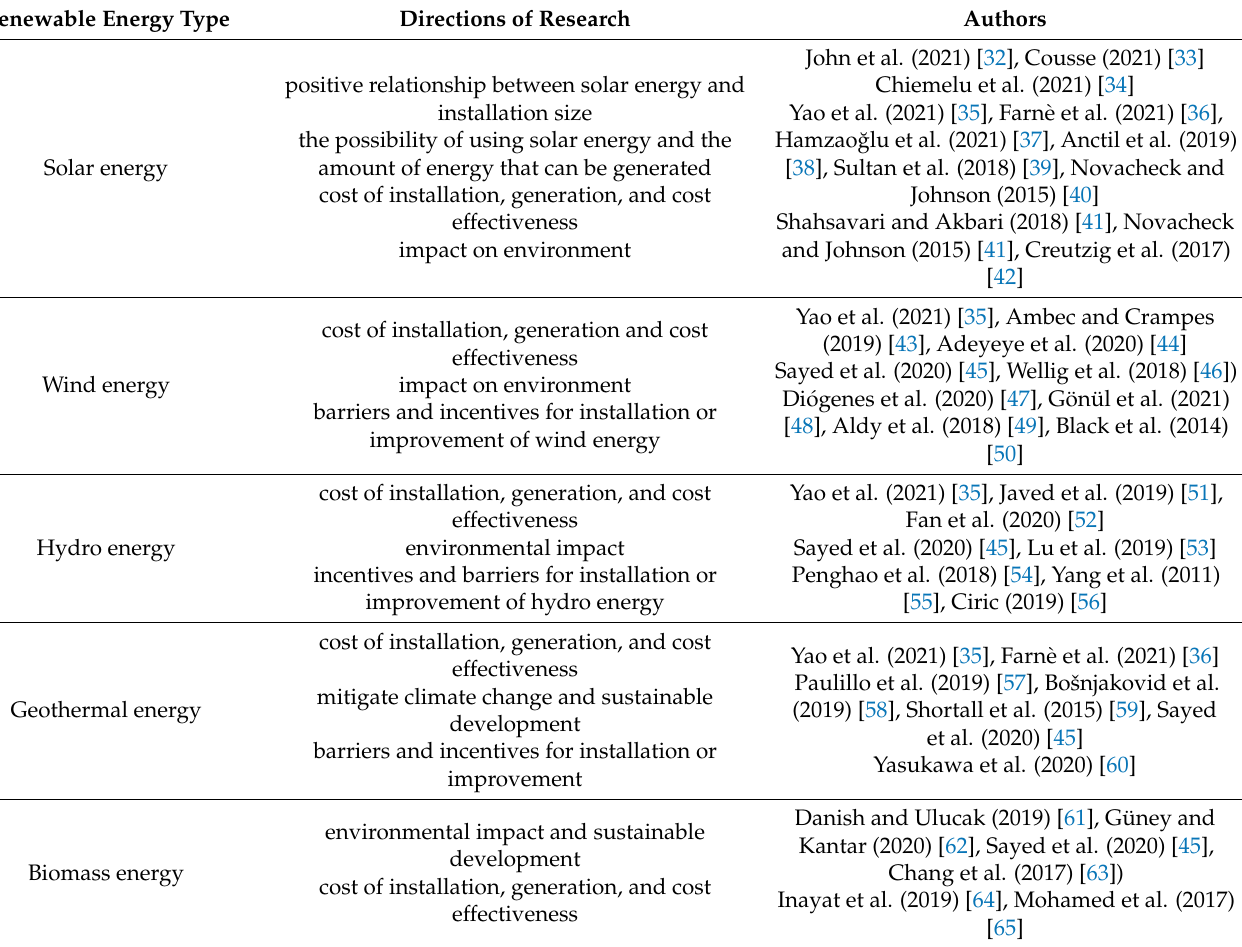
Table 1. Research directions in the field of types of renewable